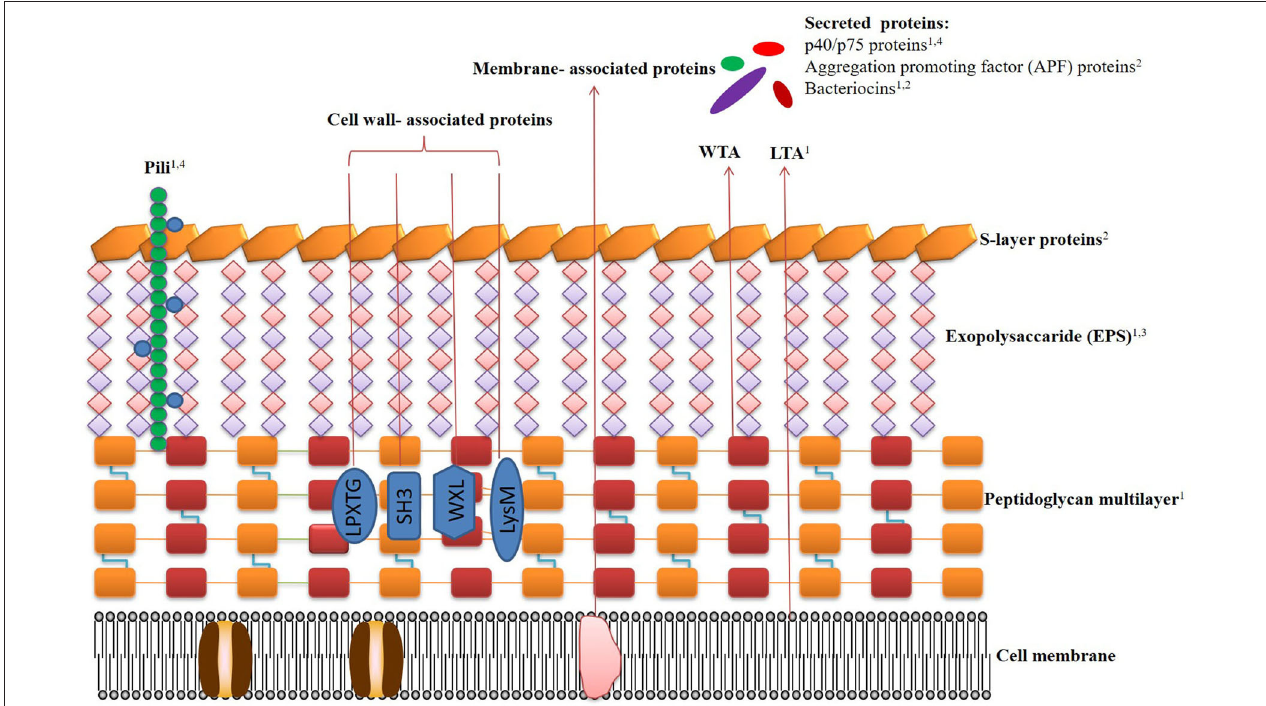
FIGURE 1 | Schematic representation of the cell surface architecture of Lactobacilli , the bilipidic cell membrane (CM) with embedded proteins is covered by a multilayered peptidoglycan (PG) shell decorated with lipoteichoic acids (LTA), wall teichoic acids (WTA), pili, proteins, and lipoproteins. Exopolysaccharides (EPS) form a thick covering closely associated with PG and are surrounded by an outer envelope of S-layer proteins. The beneficial effects of the paraprobiotics and postbiotics are denoted by numbers. (1) immunomodulatory effects; (2) antagonistic effects against pathogens; (3) anti-tumor effects; (4) preservation of intestinal barrier. Related references are as follows. Pili : immunomodulatory effects ( 46–48), preservation of intestinal barrier (46, 72). Protein p40/p75 : immunomodulatory effects (74), preservation of intestinal barrier (17, 75–78). Aggregation promoting factor (APF) proteins : antagonistic effects against pathogens (79–83). Bacteriocins